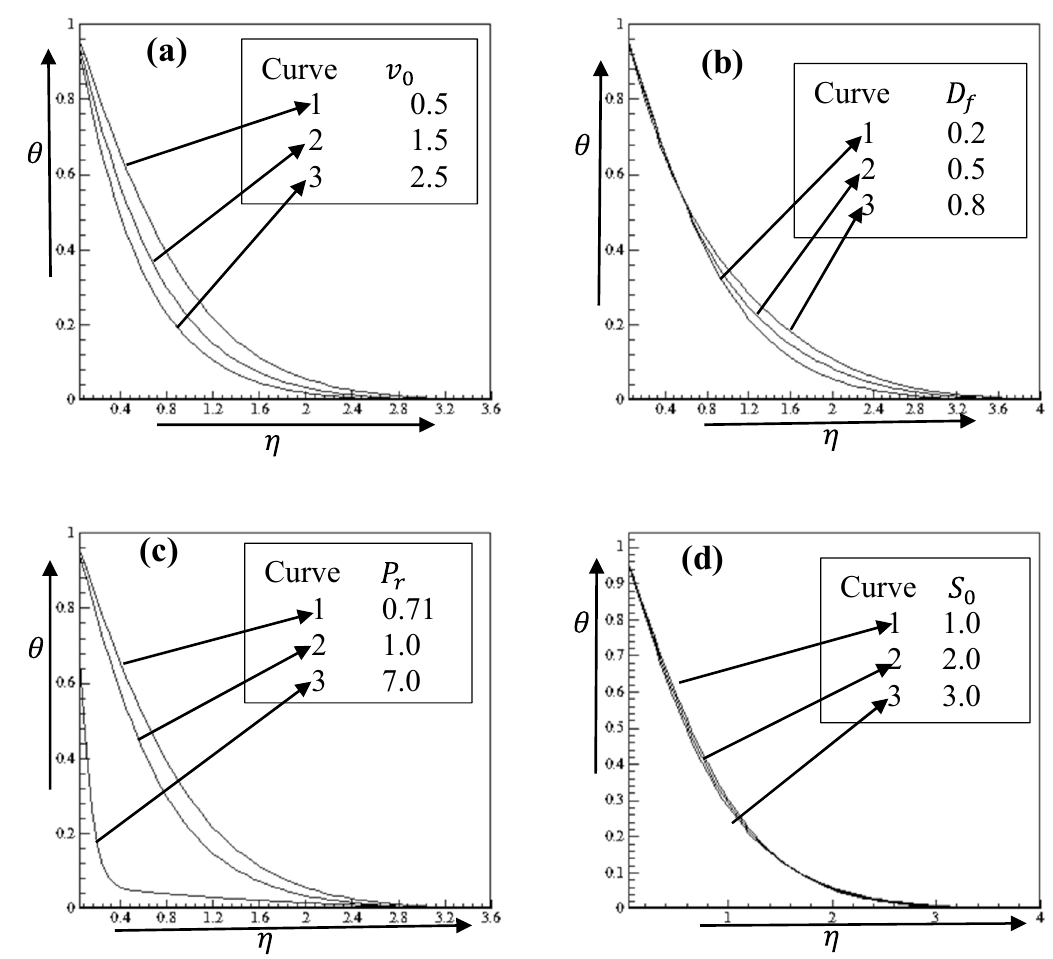
Fig. 3 Temperature profile for the variation of a v 0 , b D f , c P r , and d S